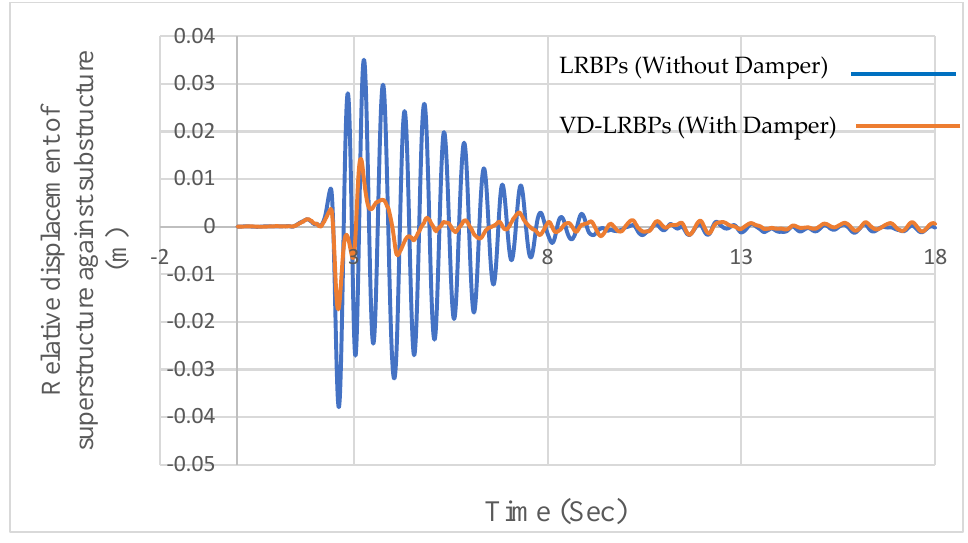
Figure 24. The relative displacement of superstructure against substructure histories under Imperial Valley (El Centro) earthquake.